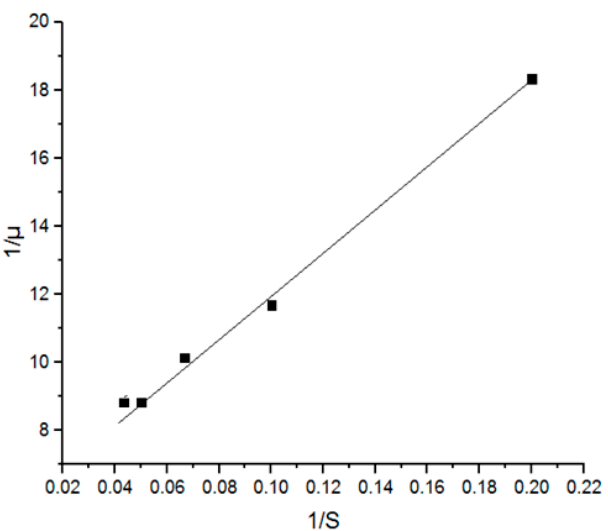
Figure 2. A Lineweaver–Burk plot estimating the µ max and K s values in a batch ethanol fermentation.